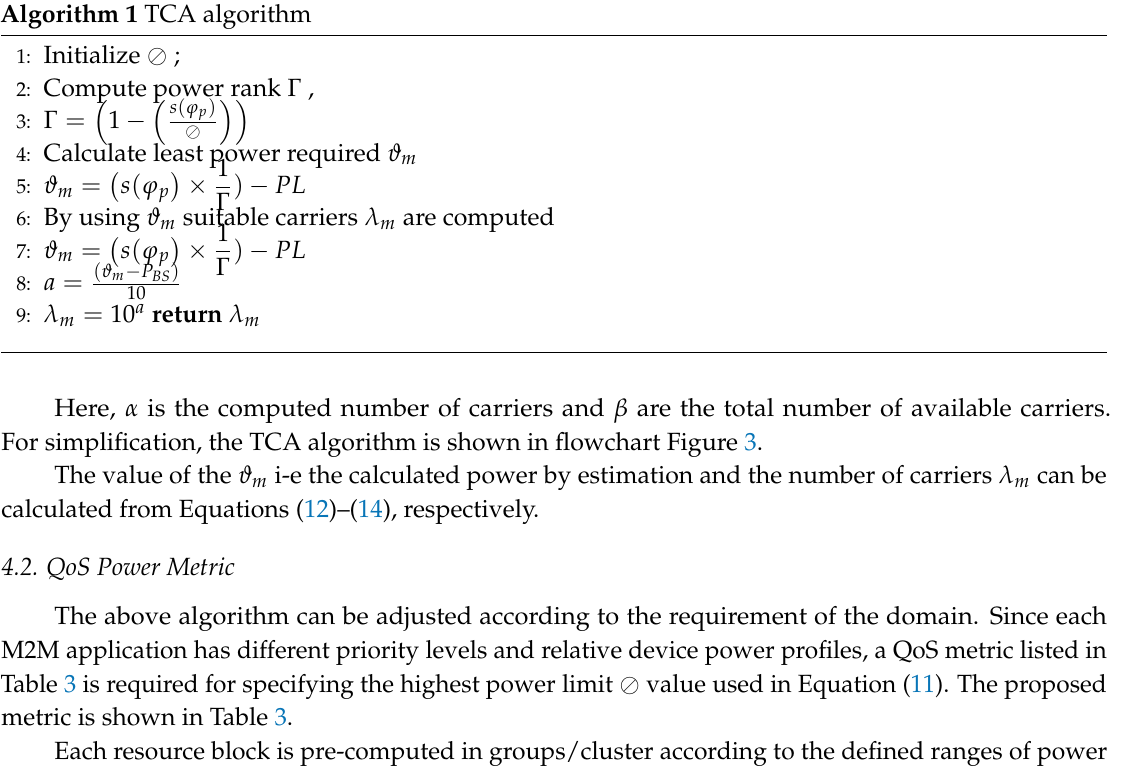
Algorithm 1 TCA